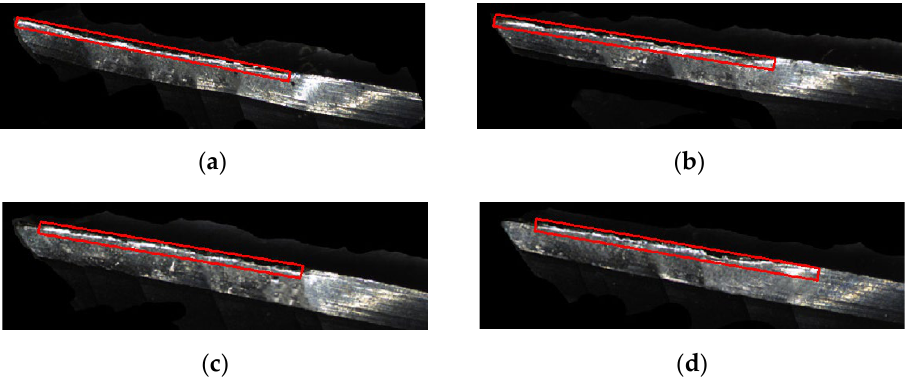
Figure 13. The minimum circumscribed rectangle of side edge wear area. ( a ) The first edge; ( b ) The second edge; ( c ) The third edge; ( d ) The fourth edge.